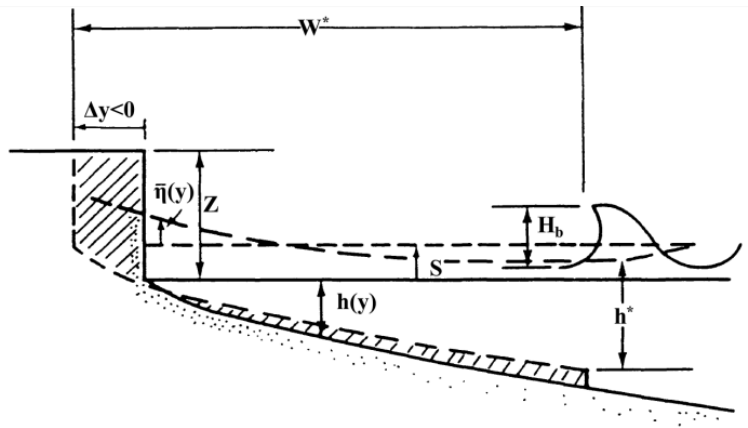
Figure 1. Profile geometry and notation for shoreline recession due to waves and increased water level (adapted from [17]).